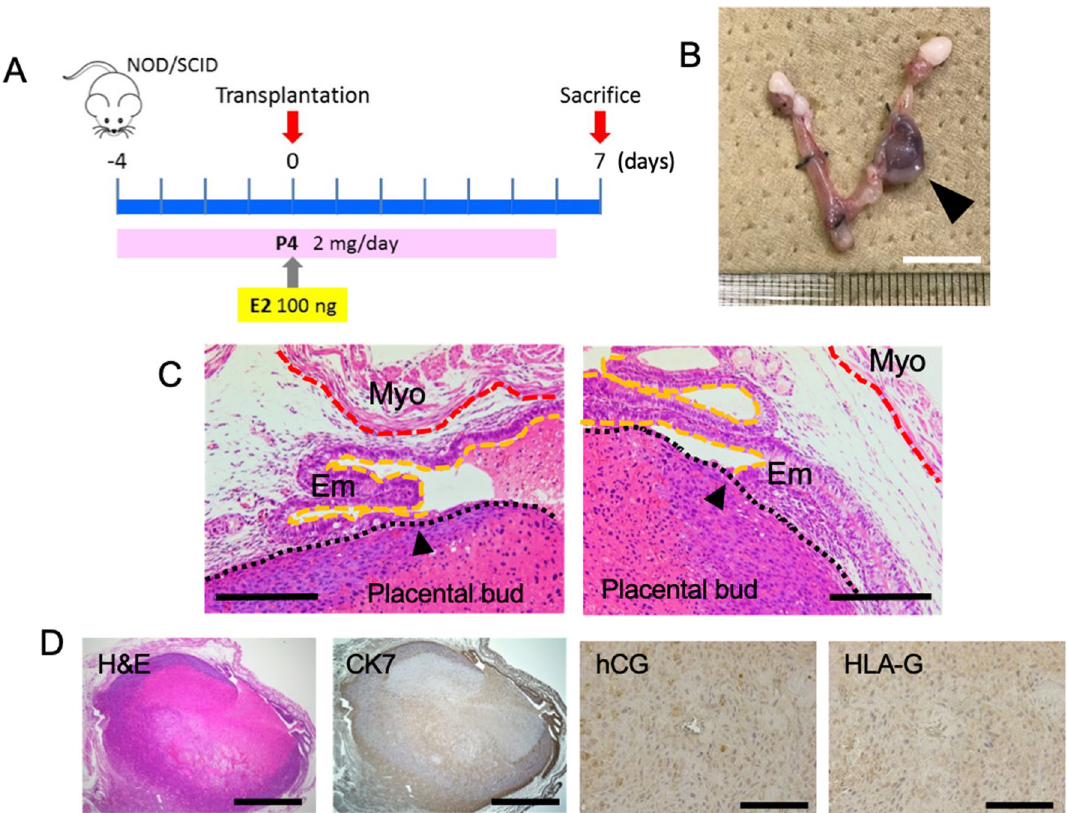
Figure 4. Transplantation of placental buds into NOD/SCID mice. ( A ) A schematic diagram of placental bud transplantation. E2, estradiol; P4, progesterone. ( B ) Macroscopic image of the engrafted placental bud (case 1). Bar, 1 cm. ( C ) H&E staining of engrafted placental organ bud (case 1). A black arrow head indicates the border between bud and endometrium. Myo: myometrium, Em: endometrium. Bars, 200 µm. ( D ) H&E staining